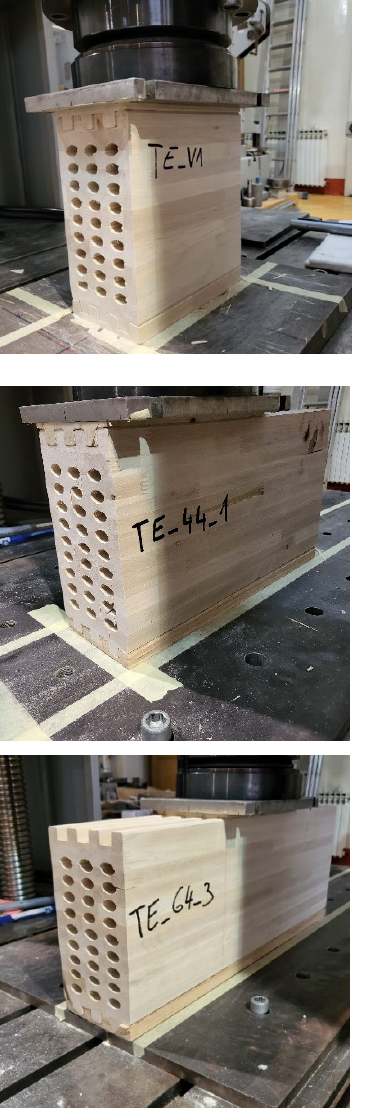
( f ) Figure 6. Positioning and loading of specimens, respect to the axis direction and boundary condi- tions: ( a ) Specimen loaded over entire face in the strong-axe direction (four groups); ( b ) specimen loaded over entire face in the week-axis direction (four groups); ( c ) specimen loaded on the edge in the strong-axis direction (three groups); ( d ) specimen loaded on the edge in the week-axis direction (three groups); ( e ) specimen loaded in the middle in the strong-axis direction (three groups); ( f ) specimen loaded in the middle in the week-axis direction (three groups). While the hollow timber elements can be seen in the image above, the full normal ones are the same, but completely without the elliptical holes. As it can be seen in Figure